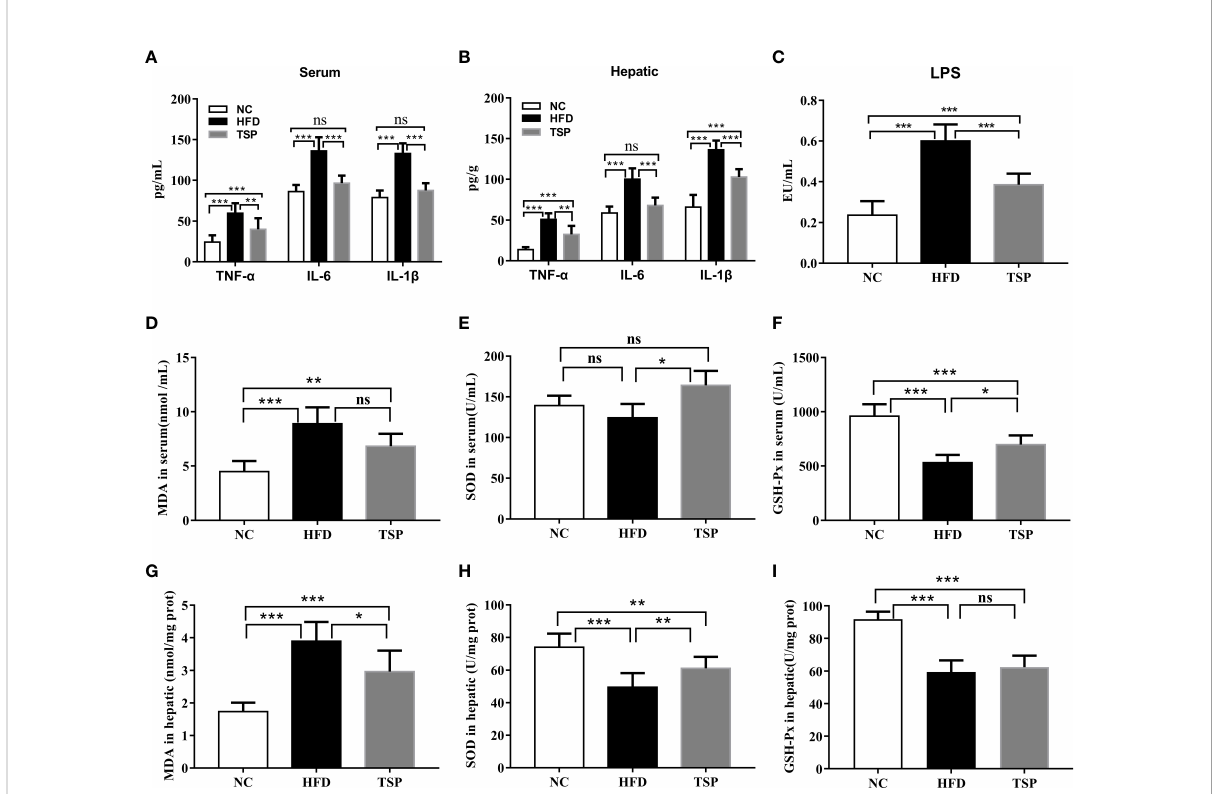
FIGURE 4 Effect of TSP on in fl ammation in serum (A) and in hepatic, (B) Effect of TSP on LPS, (C) MDA level and antioxidative enzymes (SOD, GSH-Px) in serum, (D – F) and in hepatic (G-I) . Data are expressed as means ± SD (n = 8), * p < 0.05, ** p < 0.01, and *** p < 0.001, ns, no signi fi cant p >